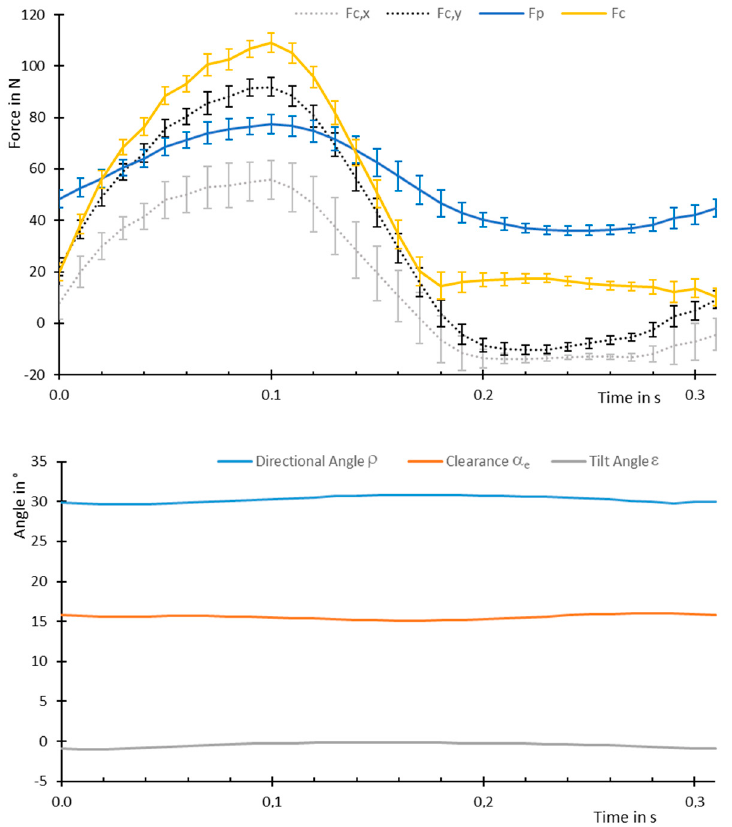
Figure 9. Average values of forces and tool orientation of 30 scraping cycles. Error bars indicate the standard deviation.